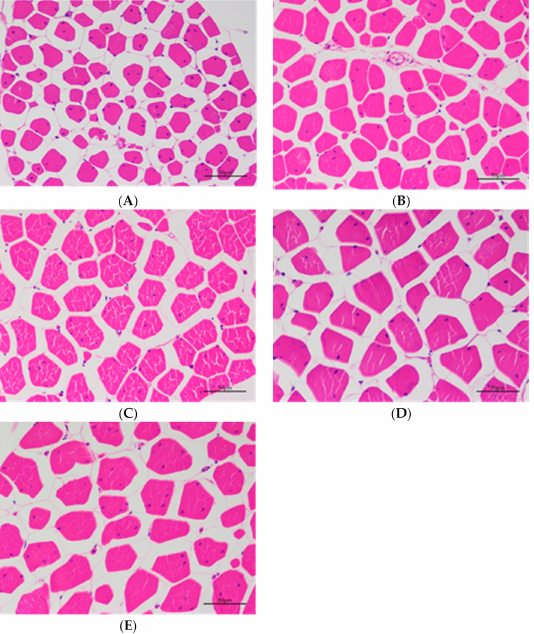
Figure 1. Histological evaluation of muscle fibers in samples with di ff erent slaughter age (400 ×